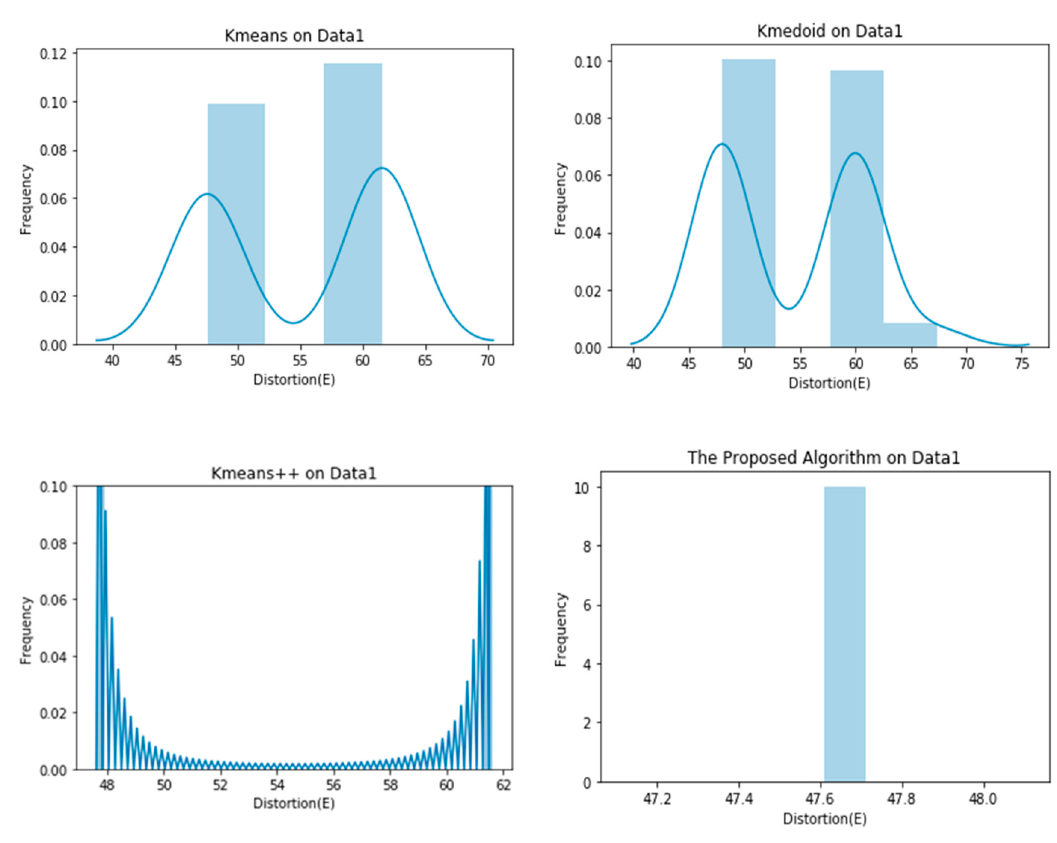
Figure 4. Graphical representation of E obtained by 100 runs of different algorithms on Data1.